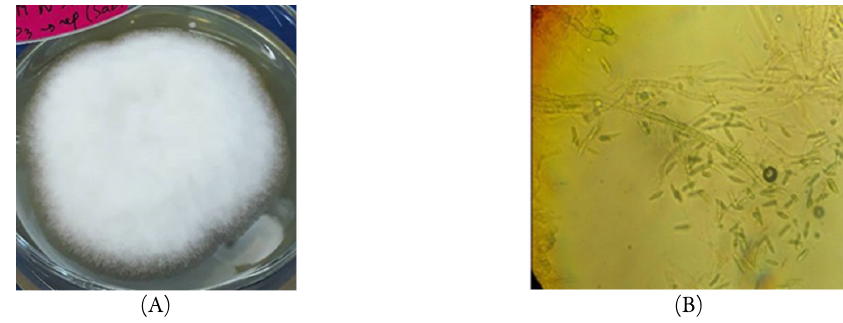
Figure 2. Result of macro and microscopic observation of endophytic isolate ENb; (A) macroscopic